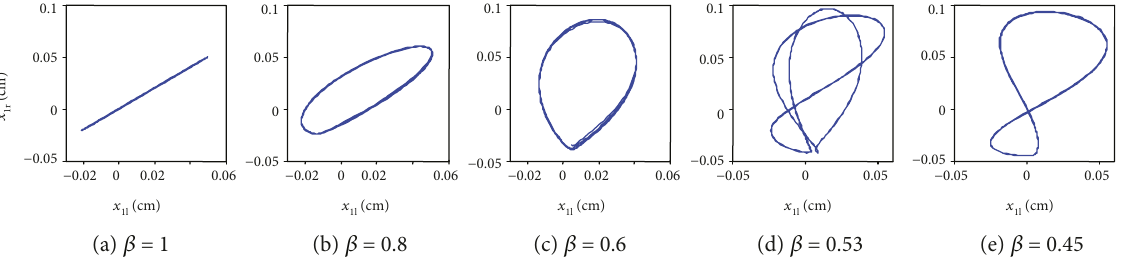
Figure 4: Phase space portrait in the x